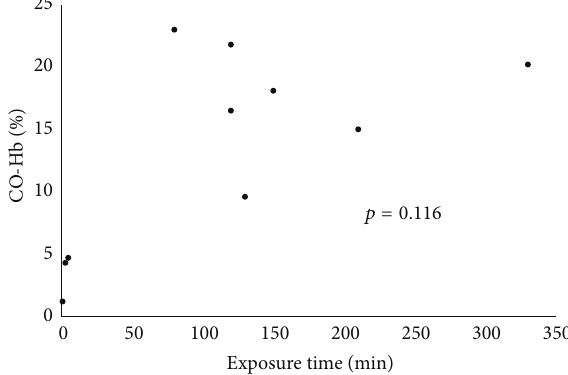
Figure 2: Laboratory blood gas analysis data (CO-Hb) versus the exposure